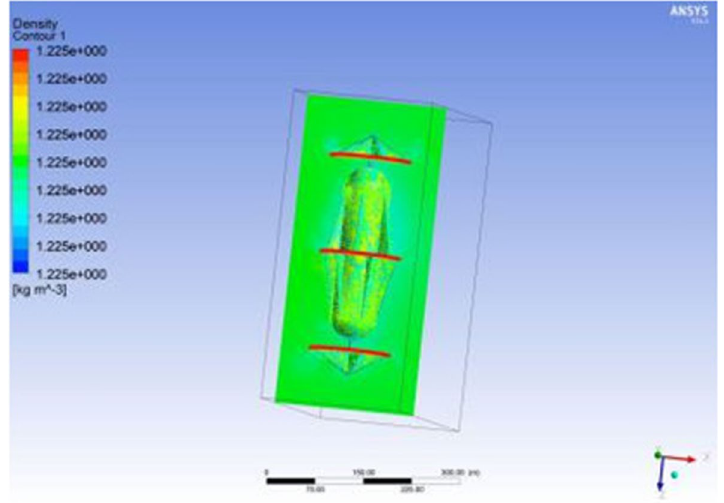
Fig. 5 Balloon density distribution in the XOZ plane‑wind speed 10 m/s and wind direction 0° (ANSYS Fluent 12.0 2009; Vasilescu and Dinu